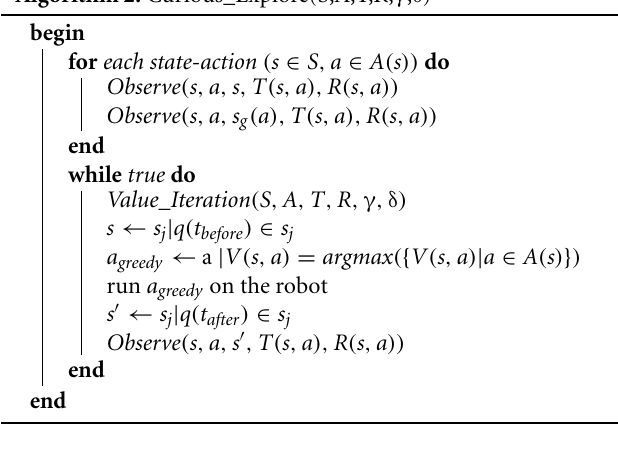
Algorithm 2: Curious_Explore(S,A,T,R, γ , δ )